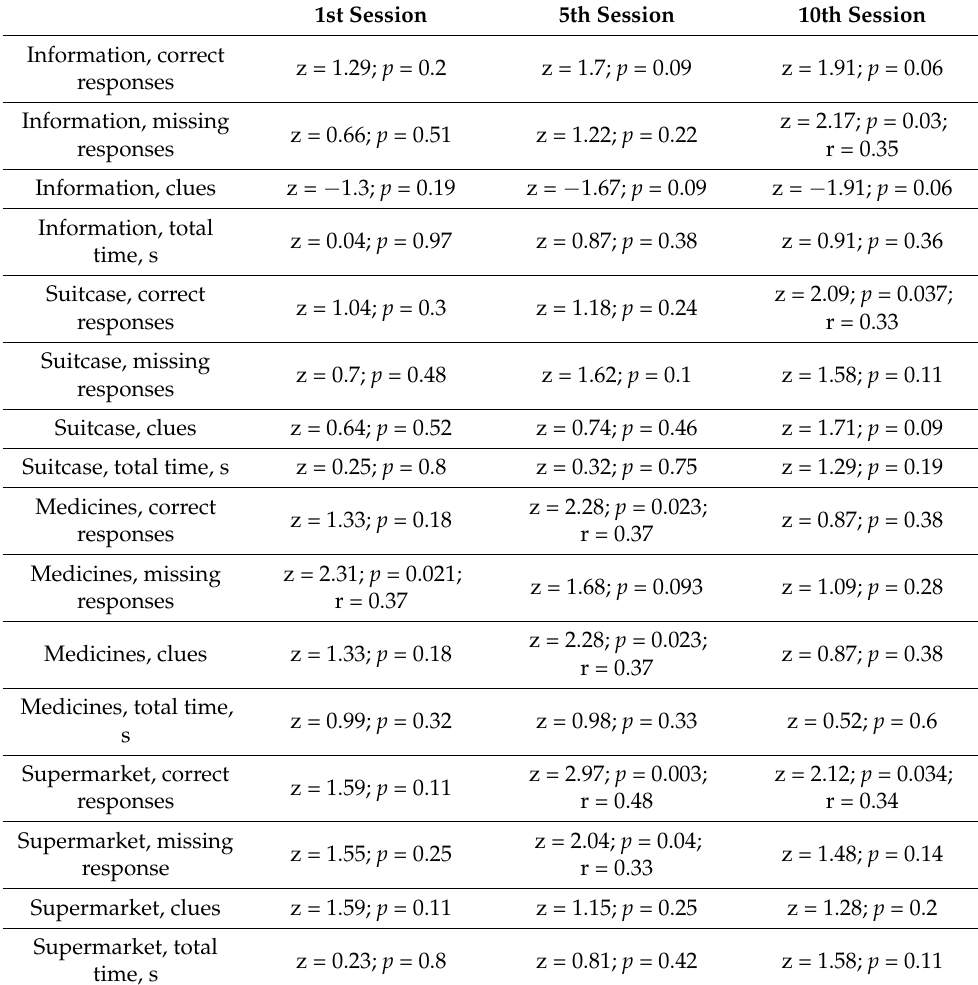
Table 4. Results of the comparisons between the EG—degenerative and non-degenerative conditions— in the 1st, 5th, and 10th sessions. 1st Session 5th Session 10th